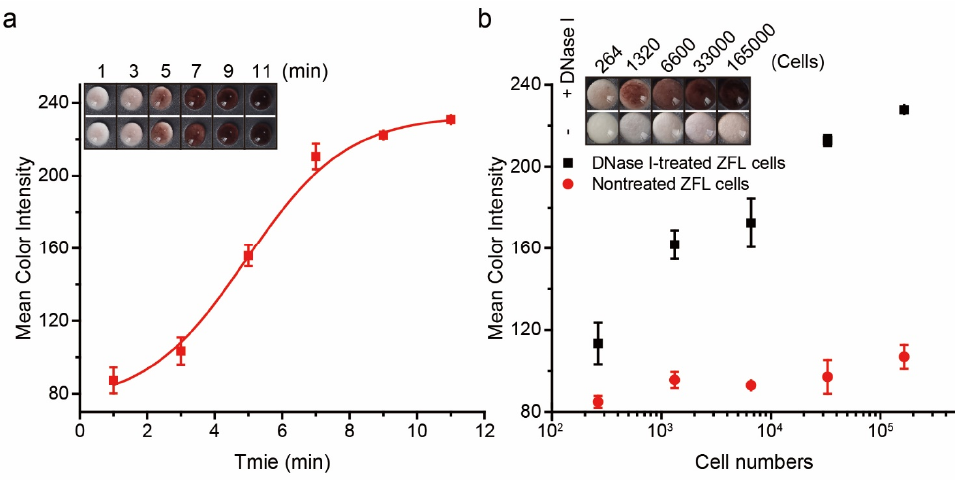
Figure 3. Effect of ( a ) the DNase I treatment time and ( b ) the amounts of damaged cells on the colorimetric response. The error bars represent standard deviations of four independent experiments.